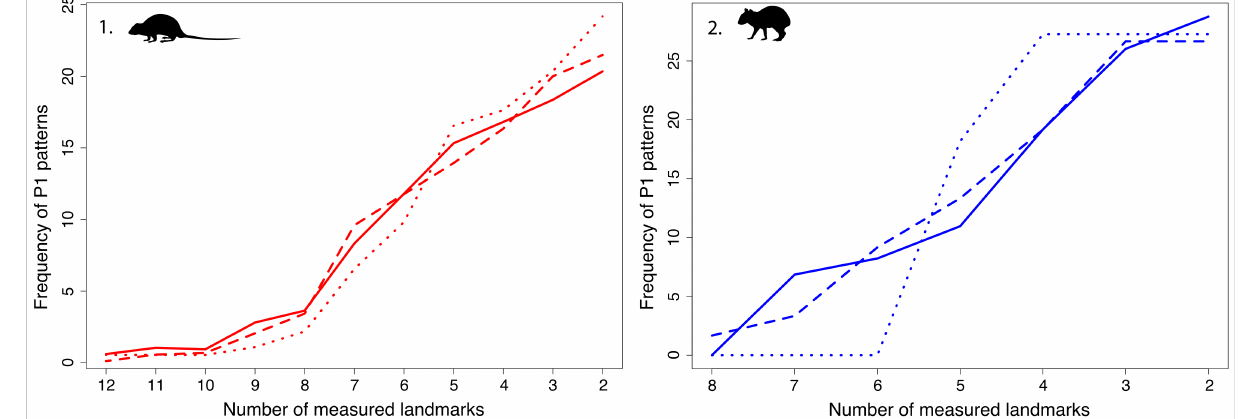
Figure 4. Frequency of the most frequent fragmentation patterns (category P1) in the assemblage, according to the three types of recovery and study of the faunal material (T-1: solid line, T-2: dashed line, T-3: dotted line), for ( 1 ) Oryzomyini mandibles and ( 2 ) Dasyprocta